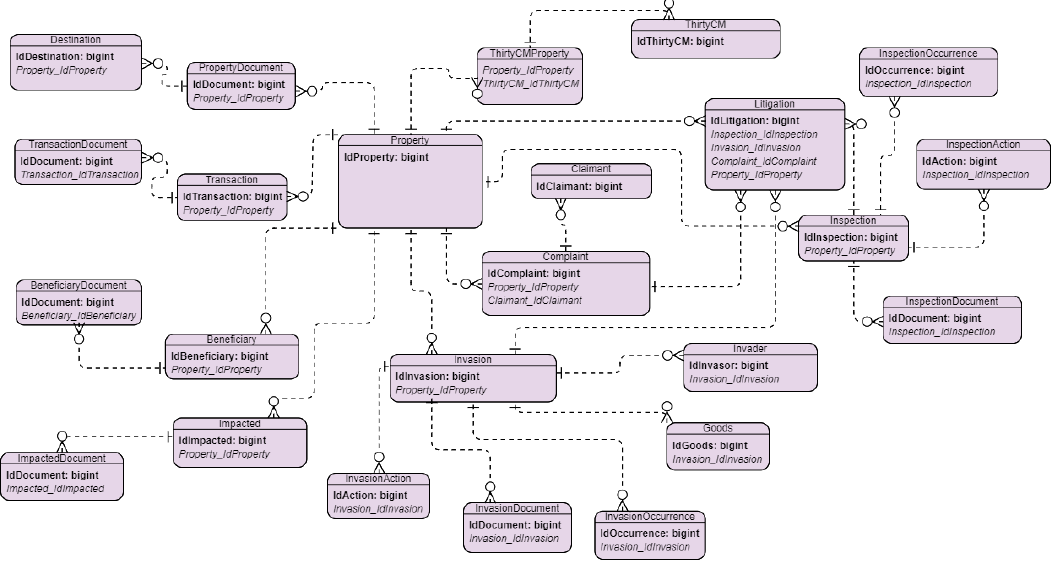
Figure 2. Entity–Relationship Data